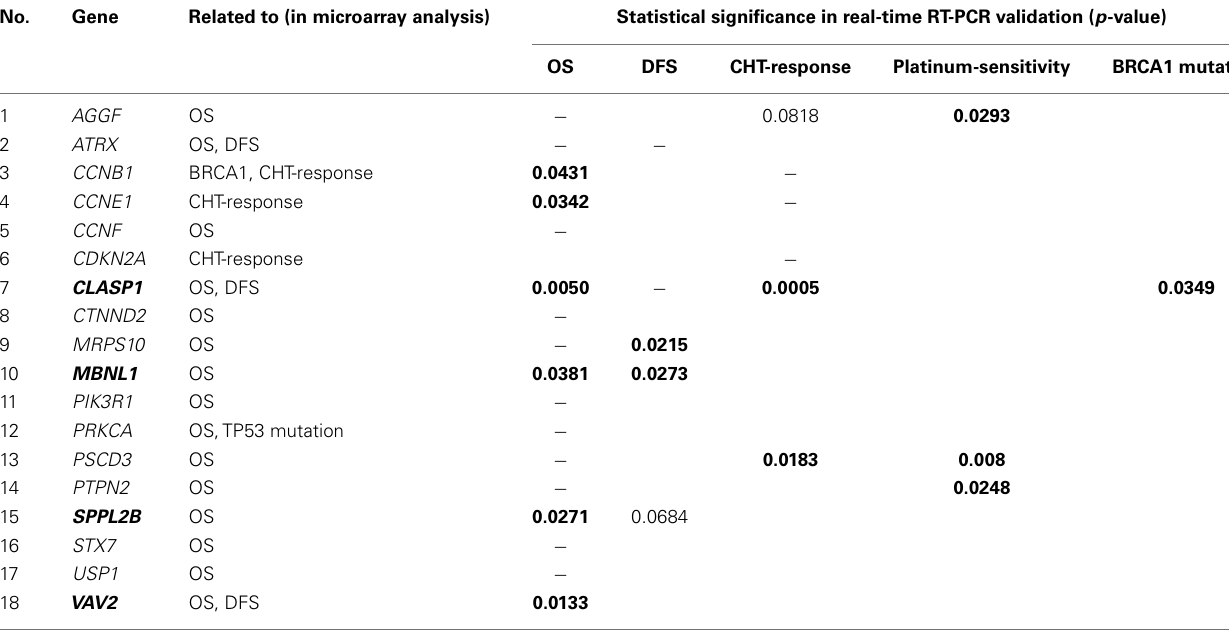
Table 5 |Technical validation of microarray results by real-time